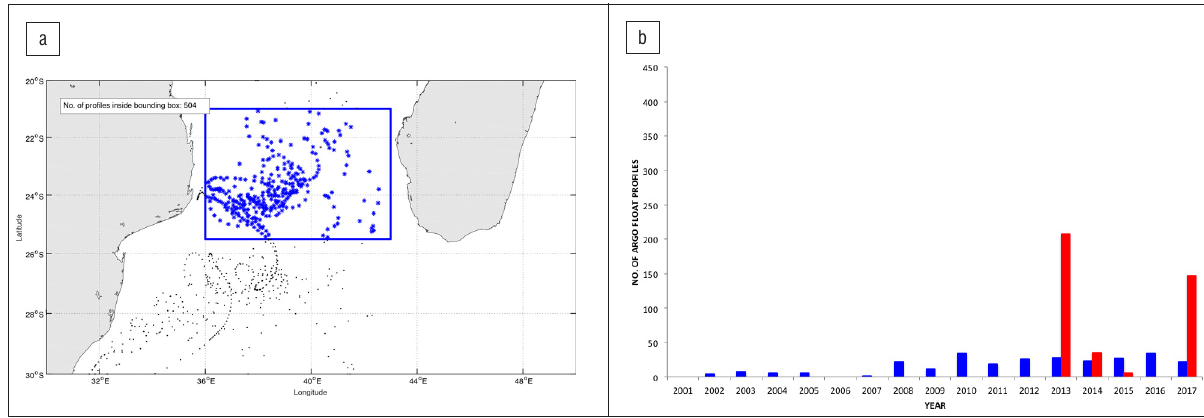
Figure 3: (a) Map of the southern Mozambique Channel for the nine high-resolution floats used in the mesoscale eddy experiments, with the southern Mozambique Channel region depicted as a blue rectangle. (b) Histogram depicting, within the Mozambique Channel bounding box, the profiles from standard profiling Argo floats (blue) and high-resolution Argo floats (red) per